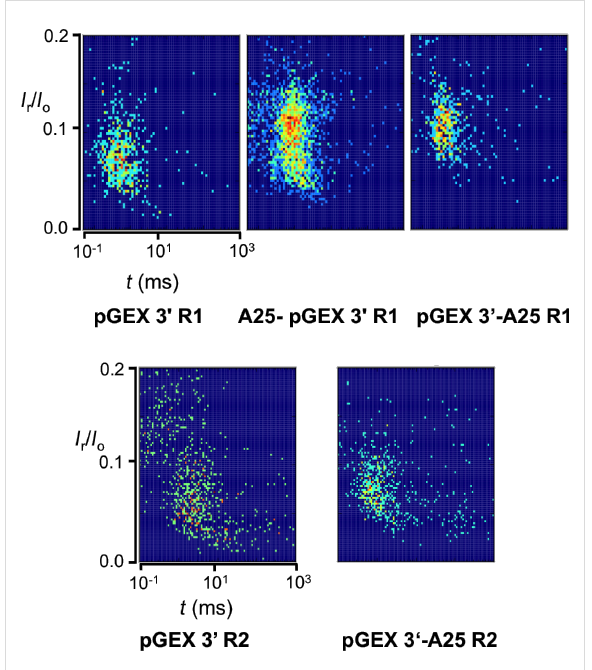
Figure 6: Heat plots, normalized residual current, I r / I 0 , vs transloca- tion time, t (ms), for the deoxyoligos with multiple osmylated pyrim- idines. pGEX3’ is a 23 nt long PCR primer; R1 stands for 4 dT(OsBp) and R2 stands for {4 dT(OsBp)+5 dC(OsBp)}. Event plots with R1 ex- hibit a single population. Event plots with R2 exhibit, at least, two populations consistent with other mechanisms operating besides single molecule translocation. pGEX3’-A 25 R2 exhibits a third popula- tion (not shown) at times longer than 1 s. In all cases the A 25 -tail